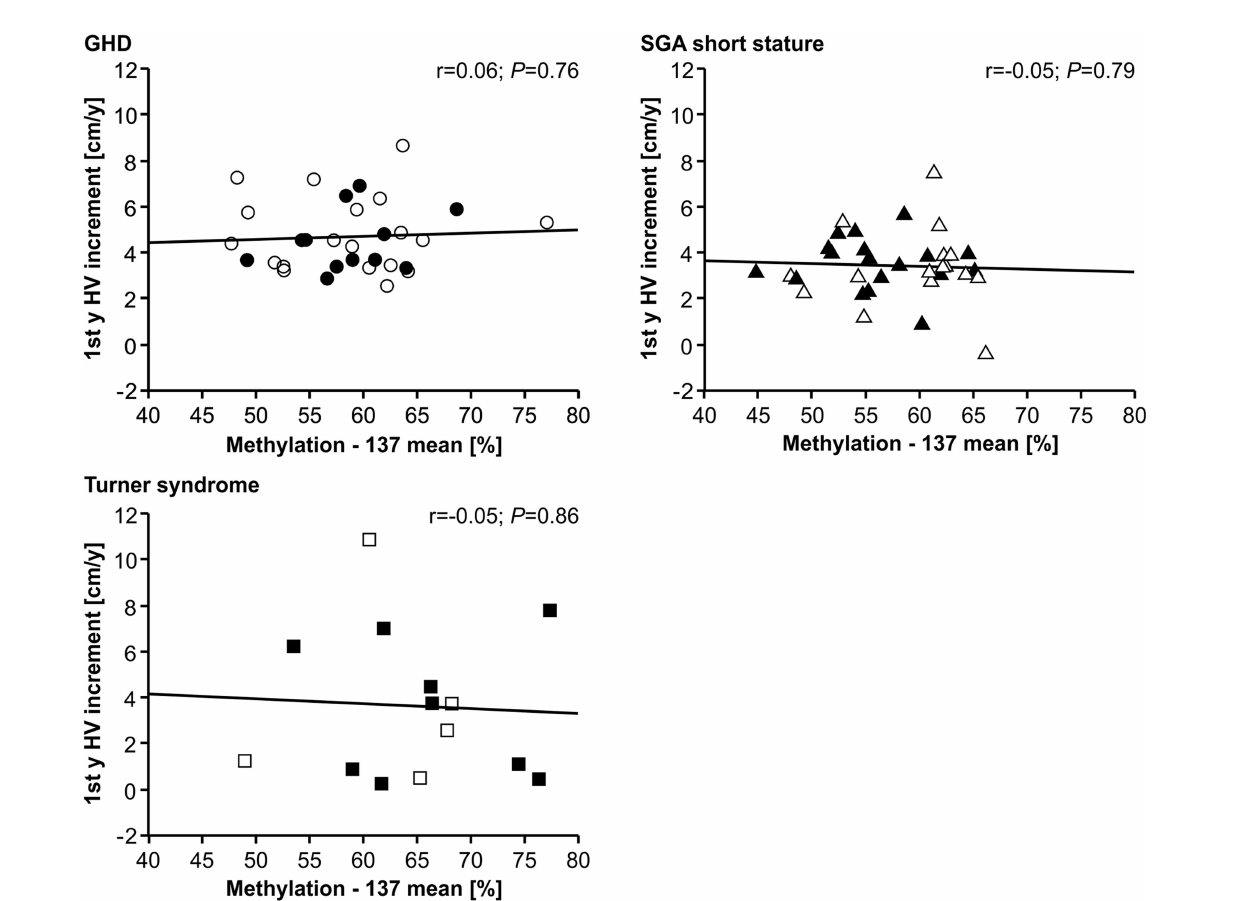
FIGURE 2 | First year height velocity increment (1 st y HV increment) and IGF1 P2 methylation at position -137 in blood of children with GHD, SGA short stature and Turner syndrome treated with rhGH. Filled symbols indicate patients with exon3-deleted GHR